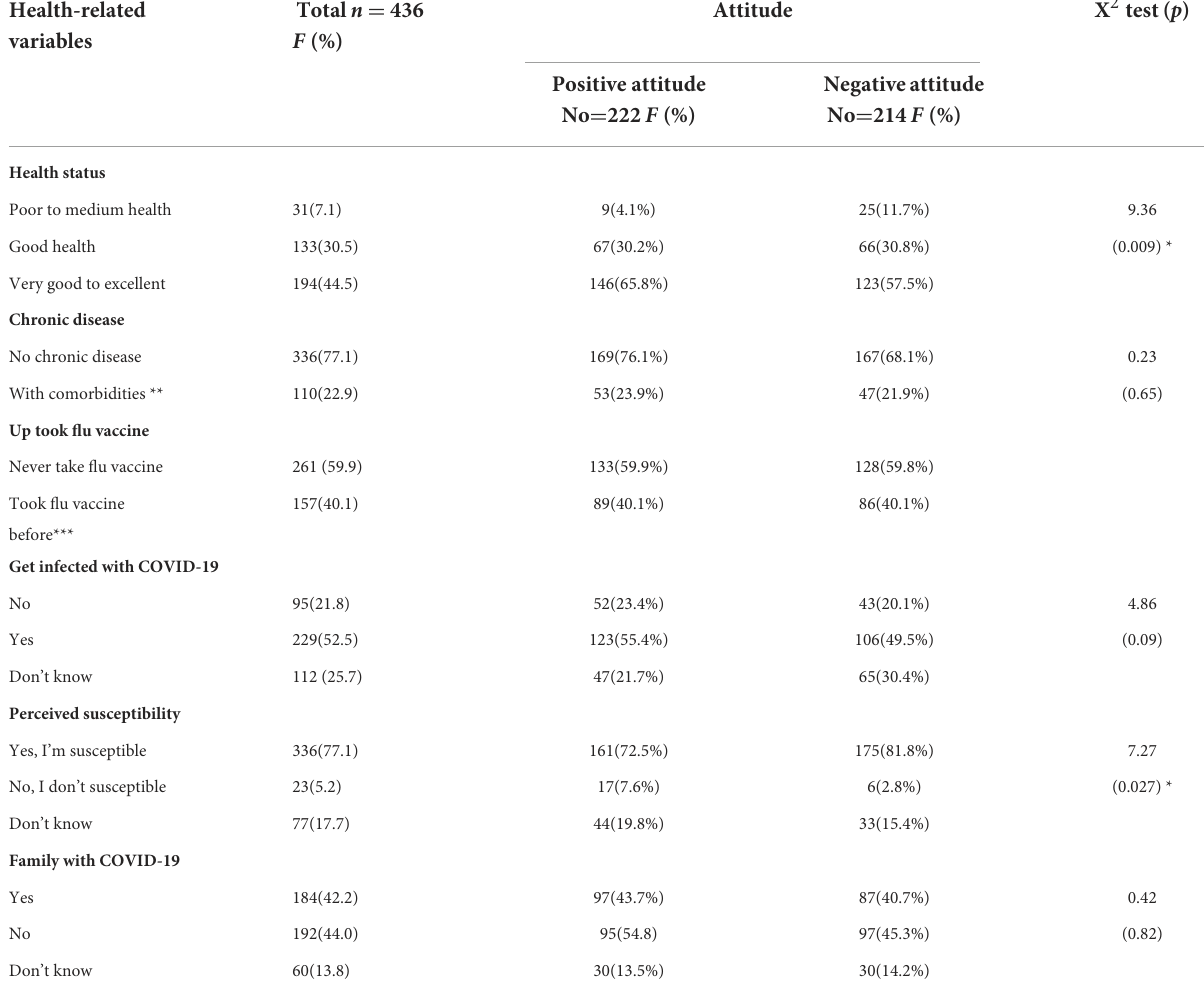
TABLE 2 Association between the physicians’ attitude toward COVID-19 vaccine uptake and health-related factors.